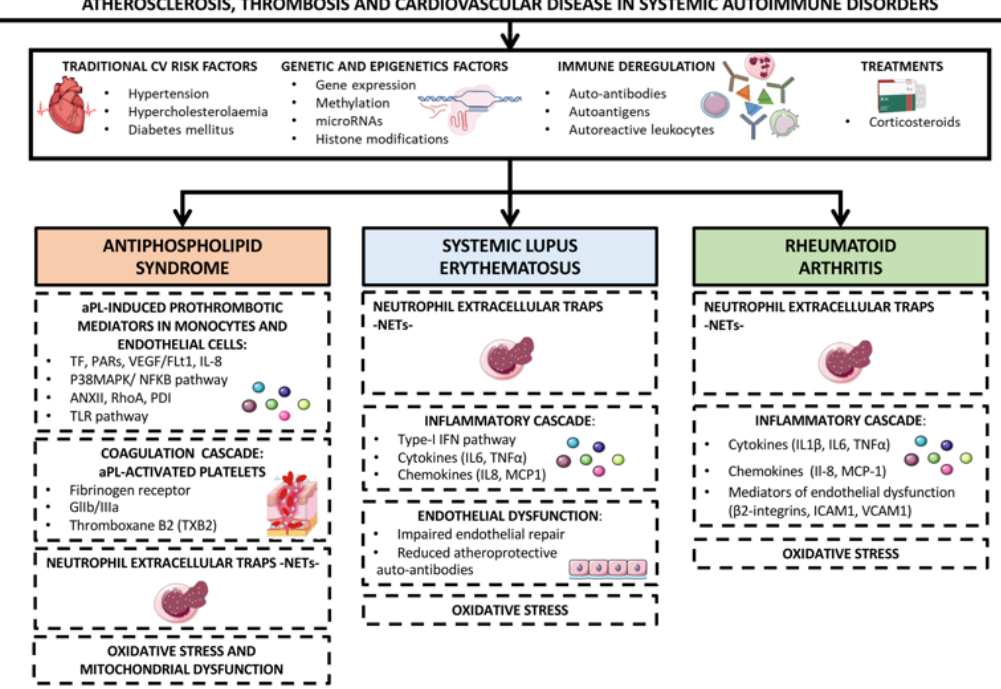
Figure 1. Mechanisms of atherosclerosis, thrombosis and cardiovascular disease in systemic autoimmune disorders. Rheumatoid arthritis (RA) Systemic lupus erythematosus (SLE) and antiphospholipid syndrome (APS) are the systemic autoimmune diseases most directly associated with an increased risk of developing cardiovascular (CV) events. CVD in these autoimmune disorders is thought to happen as the result of a complex interaction between traditional CV risk factors (i.e., hypertension, hypercholesterolaemia, diabetes mellitus), immune deregulation (involving auto-antibodies, autoantigens and autoreactive leukocytes), corticosteroids treatment and disease activity. In addition, oxidative stress and mitochondrial dysfunction, dyslipidemia, endothelial dysfunction, systemic inflammatory mediators -cytokines, chemokines, adipokines, proteases, adhesion receptors, products of NETosis, and intracellular signaling molecules- and prothrombotic molecules have been implicated in the development of these vascular pathologies. Genetic and epigenetic analyses have further allowed the identification of specific signatures explaining the pro-atherothrombotic profiles of RA, SLE and APS patients.